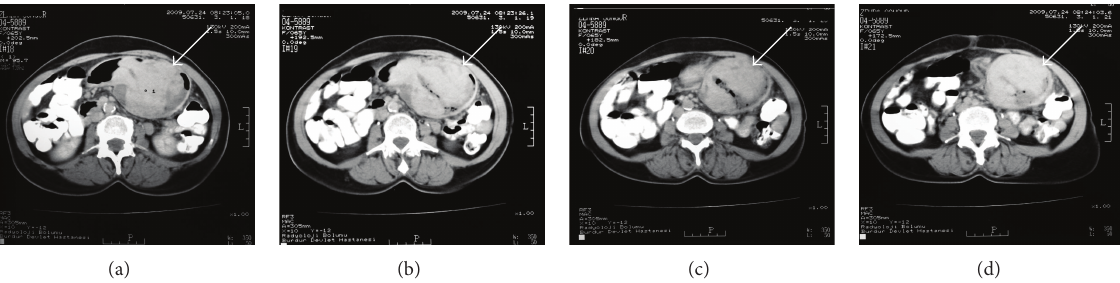
Figure 3: Abdomen computerized tomography (CT). In the right side of the abdomen midline, over the transverse column, a heterogeneous hyperdense solid mass with the size of 7 , 5 × 10 × 11 cm having cystic areas and air densities inside was determined (marked with an arrow).